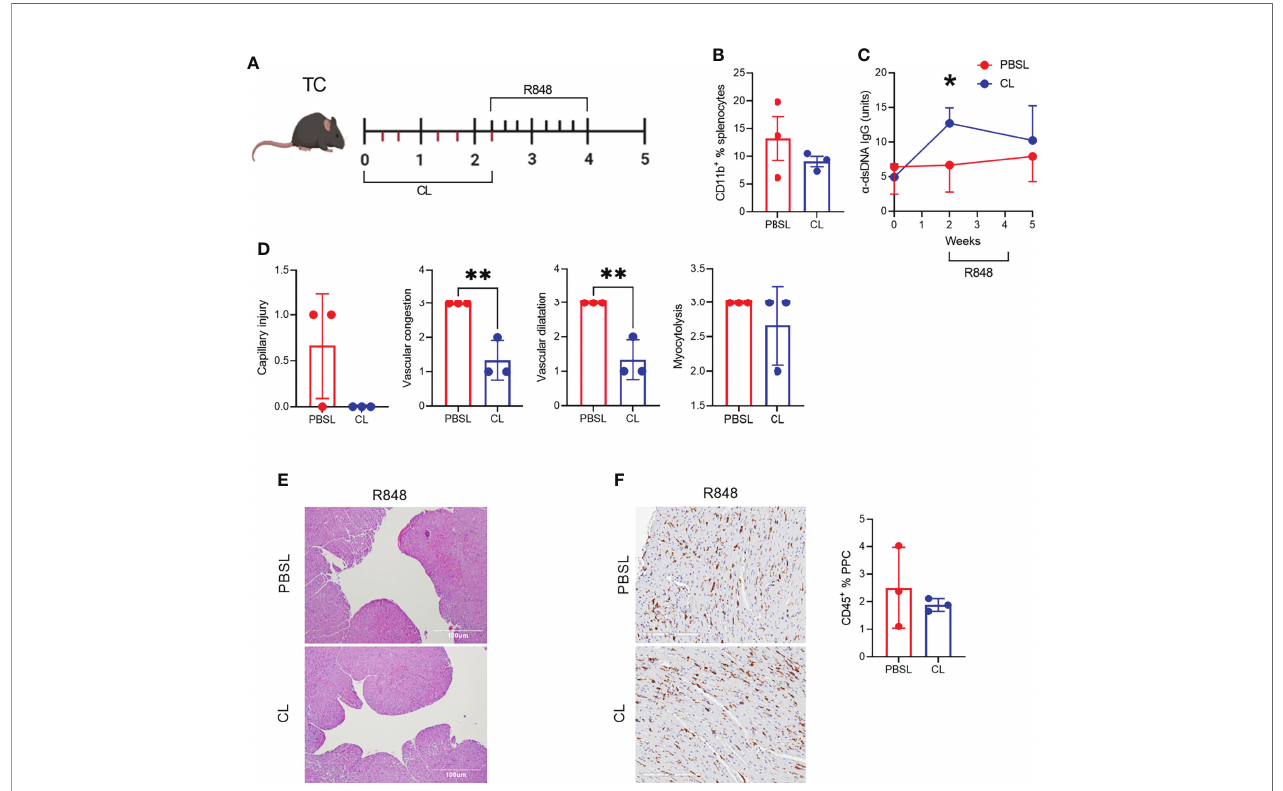
FIGURE 8 | CD11b + cell depletion decreased TLR-7-induced vascular injury. (A) Experimental design for pre-treatment with clodronate liposomes (CL) or PBS- loaded control liposomes (PBSL) before R848 treatment of pre-autoimmune TC mice. The time scale is in weeks and each tick corresponds to an injection of liposomes (bottom) or a R848 application (top). (B) . Frequency of CD11b + splenocytes. (C) Serum anti-dsDNA IgG starting at the time of CL/PBSL treatment. (D) Cardiac pathology scores. (E) Representative H&E-stained heart sections of TC mice treated with PBSL or CL (10X, scale bars: 100 um). (F) CD45 staining with representative sections on the left (20X magni fi cation, scale bar: 200 um) and quantitation of the right. n = 3 per group, t tests, *: P < 0.05, **: P <